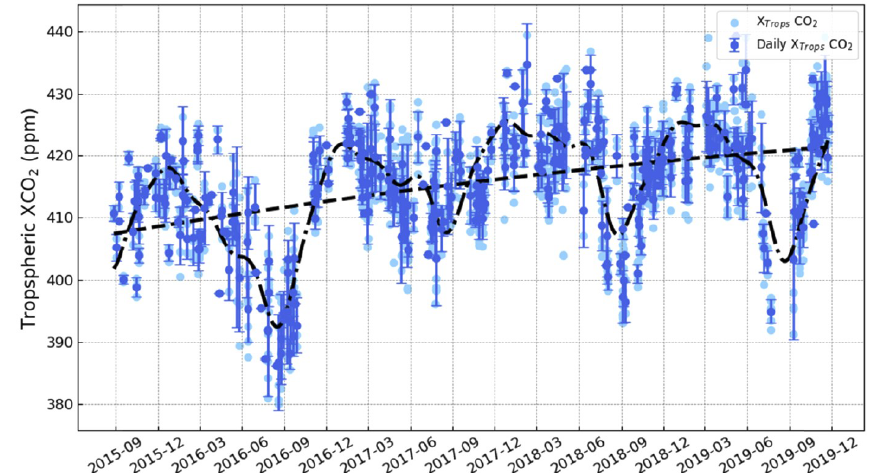
Figure 6. Ground-based FTIR CO 2 measurements at the Hefei observatory (Shan et al., 2021). The seasonality and interannual variability are represented by the black dashed curve and black dashed line, respectively, which are fitted by using a bootstrap resampling model with a third Fourier series plus a linear